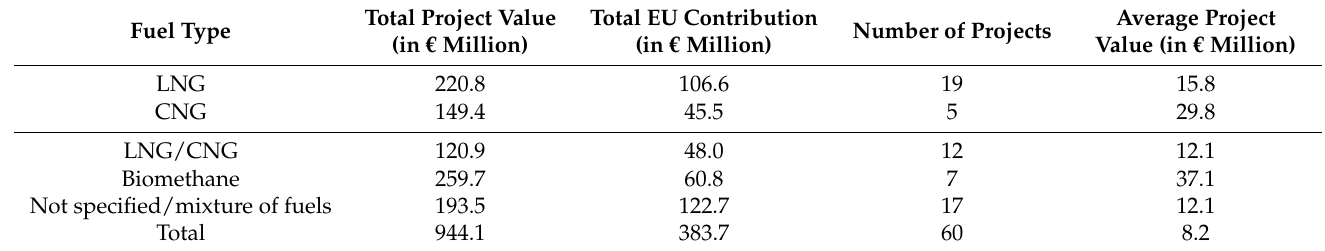
Table 3. Projects and levels of funding identified for Methane-based